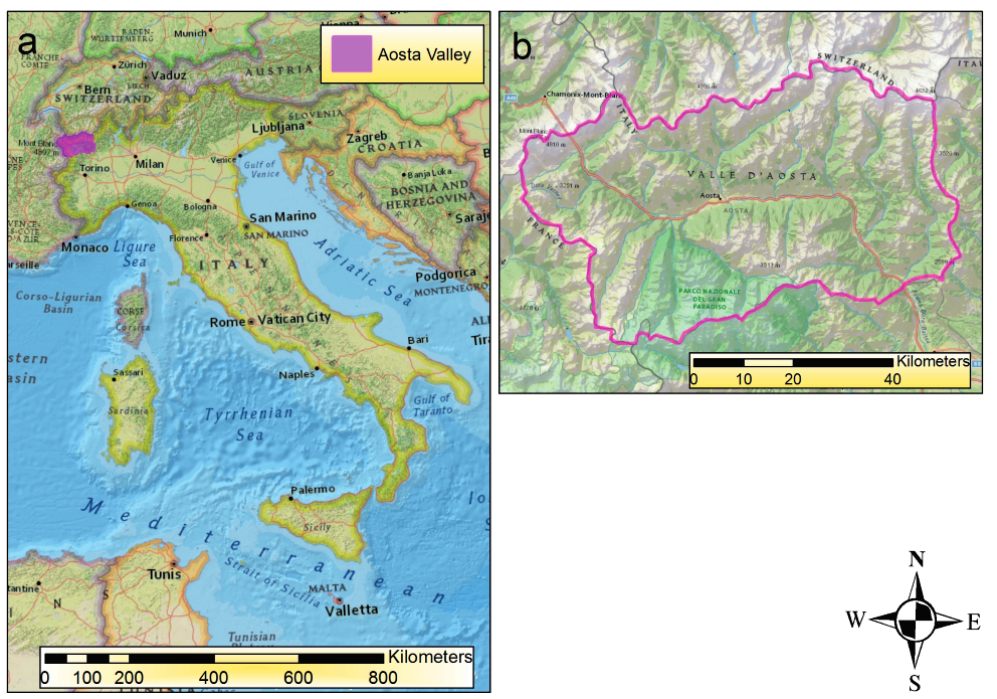
Figure 1. Overview of the study area. ( a ) Italy; ( b ) Valle d’Aosta Autonomous Region (North-West